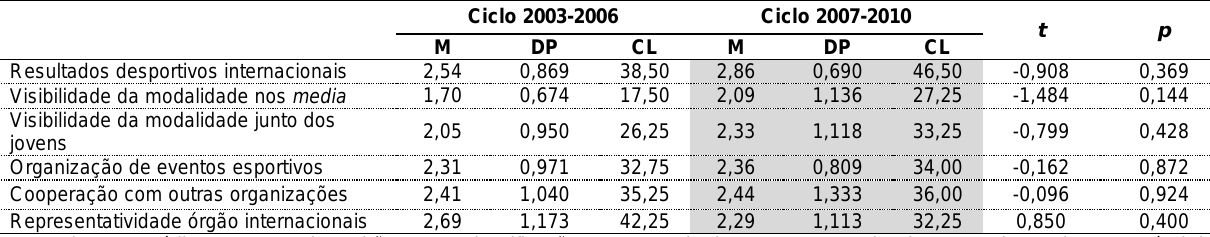
Tabela 4. Caracterização da FPAS em relação aos aspetos